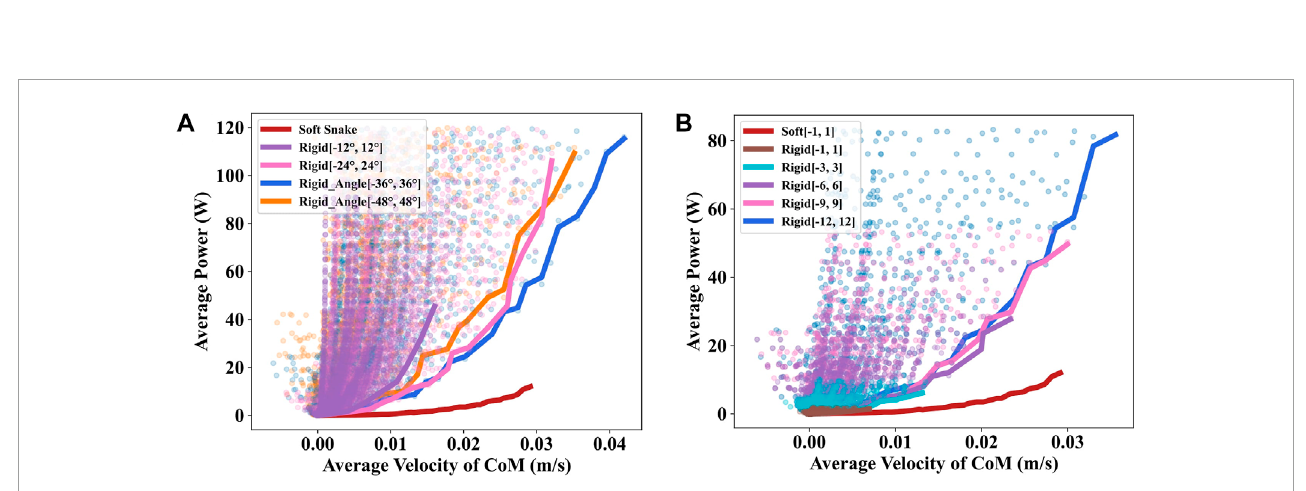
FIGURE 7 (A) Comparision of different rotation ranges of rigid snake robot’s motor. (B) Comparision of different output torque ranges of rigid snake robot’s motor.